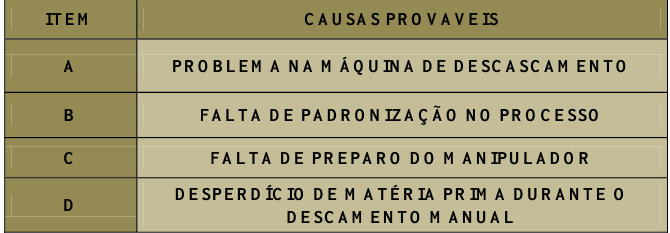
Tabela 9: Relação entre as principais causas e os itens.